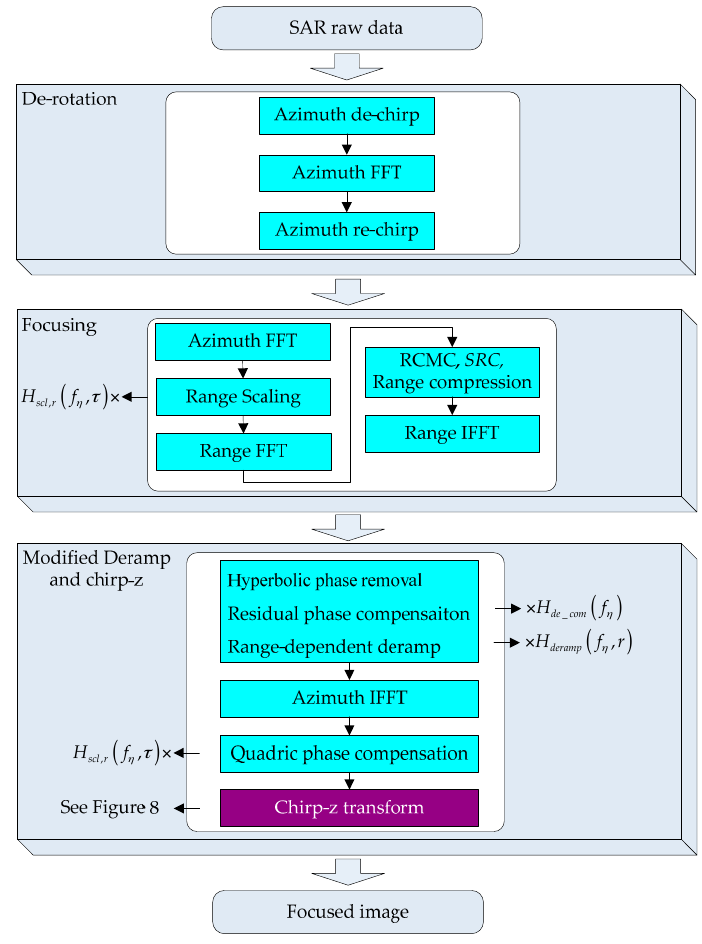
Figure 9. Flowchart of the proposed algorithm.